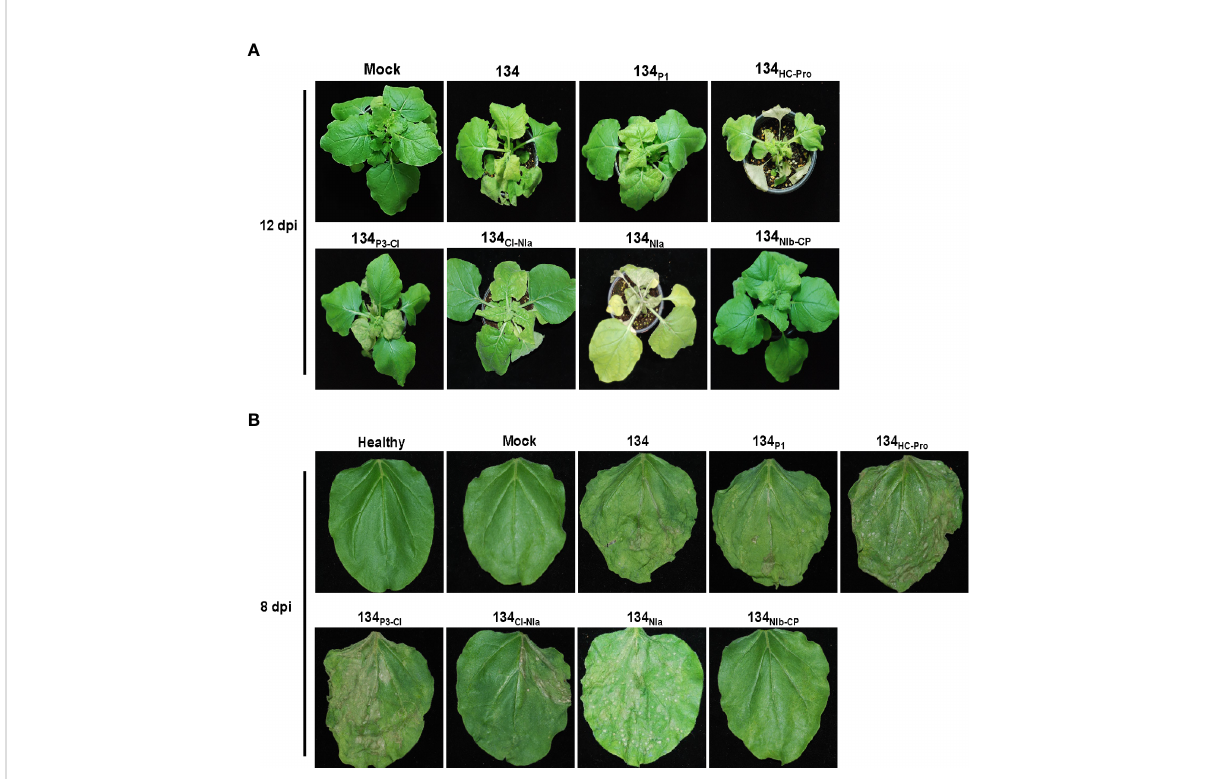
FIGURE 2 Symptom development of systemic and infected leaves on N. benthamiana plants caused by 134 and the other mutants. (A) Symptoms of 134 and chimeric mutants at 12 dpi. (B) Passage experiments with sap extracts of 134 and six chimeric mutant viruses inoculated onto N.